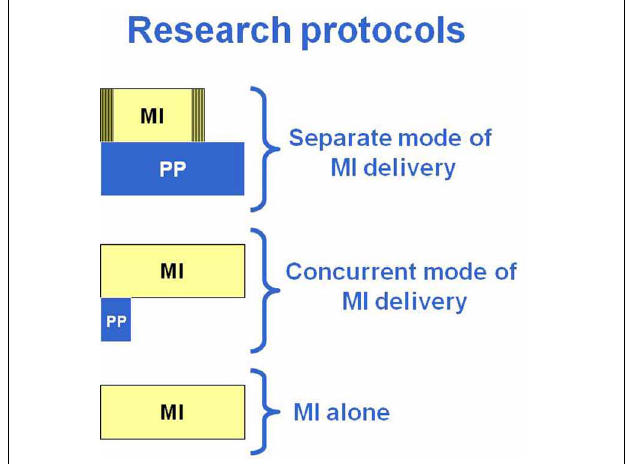
FIGURE 1 | Schematic representation of the time dedicated to Motor Imagery training (MI) and Physical Practice (PP) for each mode of MI delivery. The vertical lines indicate the proportion of time for relaxation (prior to MI) and refocusing (after MI). More time is allotted to PP than MI training in the separate mode of MI delivery, whereas in the other two modes more time is devoted to MI training.